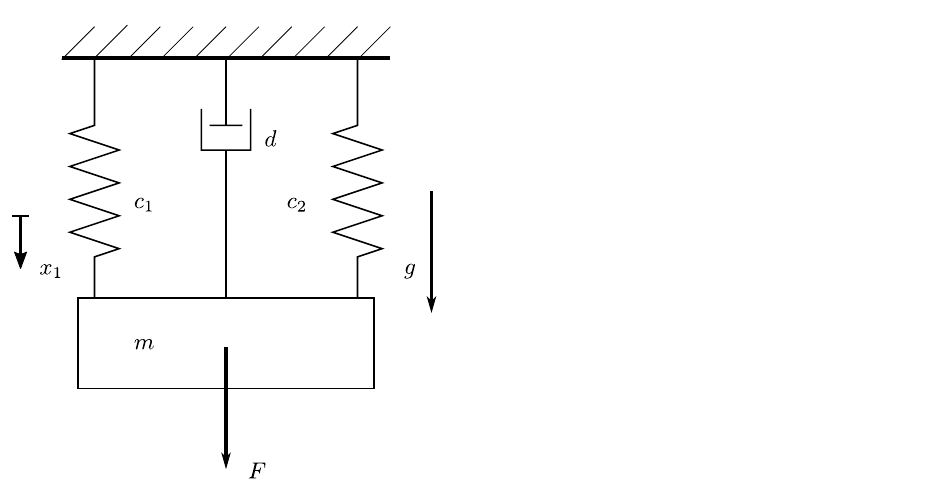
Figure 1. Mechanical sketch of the